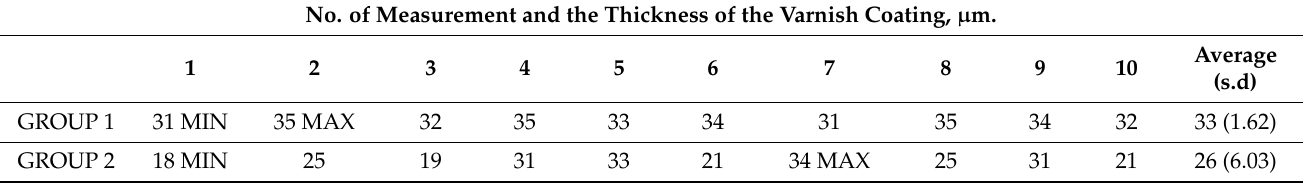
Table 2. Comparison of the varnish and zinc average coating